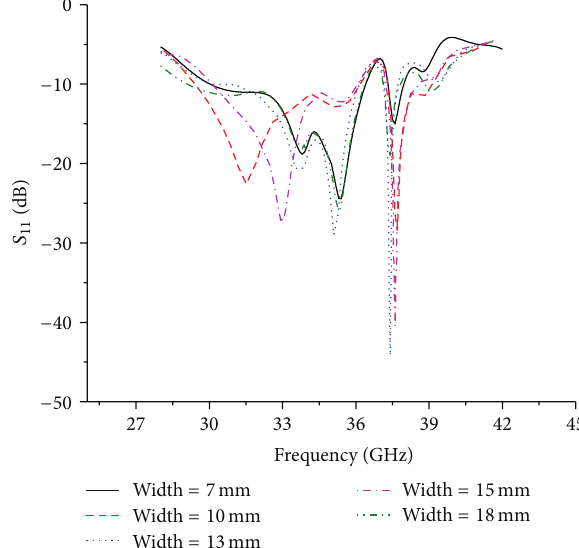
Figure 12: The simulated return loss with different width of the ground.